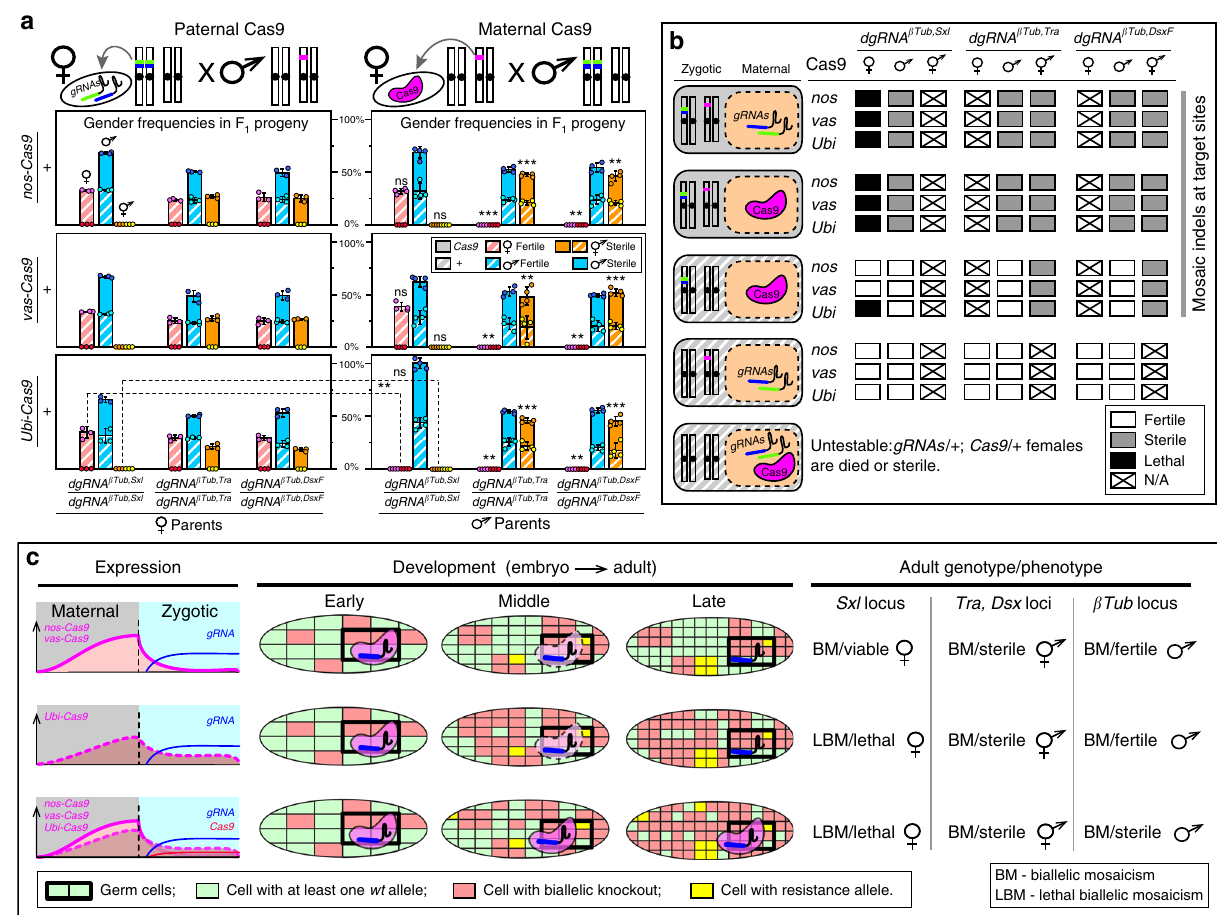
Fig. 3 Zygotic expression of CRISPR/Cas9 components ensures 100% penetrance. a Genetic quanti fi cation of dominant effect by maternal loading of Cas9 protein. Genotypes, gender frequencies, and fertility of progeny fl ies generated by reciprocal crosses between homozygous dgRNAs and heterozygous Cas9 fl ies. Bars represent means ± SD for three/four independent groups of parental fl ies. Gender frequencies from crosses with heterozygous maternal Cas9 were compared with those from the corresponding crosses with heterozygous paternal Cas9 . P > 0.01**, P > 0.001*** by a t test assuming unequal variance. Solid bars indicate inheritance of Cas9 as a gene, while striped bars indicate inheritance of + allele. b Combinations of genotypes and maternal/ zygotic contributions in embryos, and their penetrance. c Accumulation of high levels of biallelic mosaicism (BM) throughout development leads to the loss of gene function at the organismic level and ensures complete penetrance of induced phenotypes: lethality (lethal biallelic mosaicism (LBM)), female masculinization, or male sterility. Complementation of gene function in some cells by uncleaved wt alleles, and resistance alleles generated by NHEJ, are not suf fi cient to rescue the induced phenotype at the organismic level and therefore 100% of trans-heterozygous progeny have the induced phenotypes. Boxes get smaller and more abundant as cells